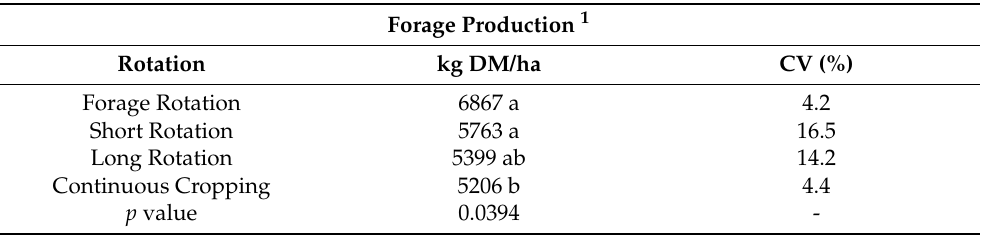
Table 6. Forage production (kg DM/ha/year) and coefficient of variation (CV%) in the ‘Palo a Pique’ pasture–crop rotations long-term experiment in Treinta y Tres,